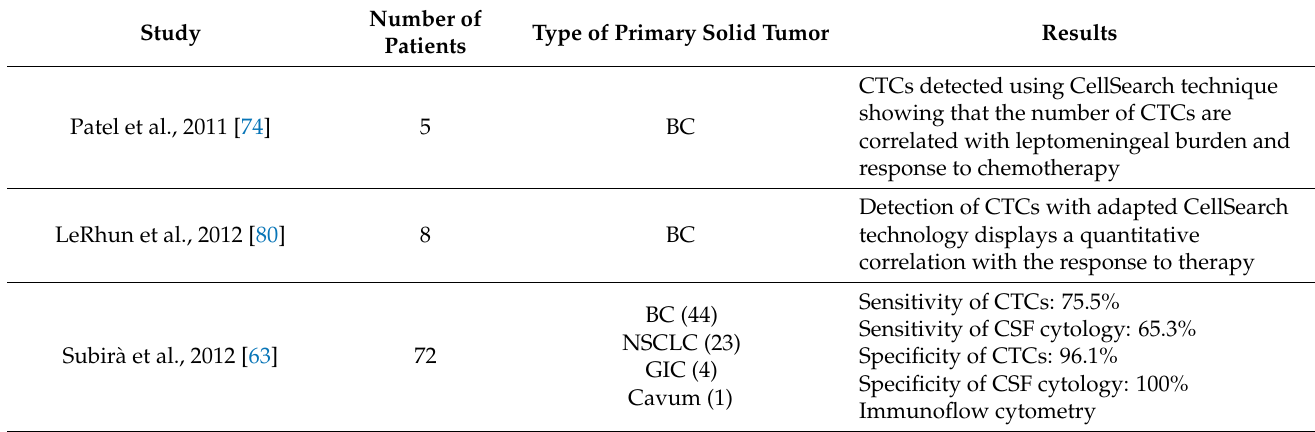
Table 2. Studies on circulating tumor cells in CSF from